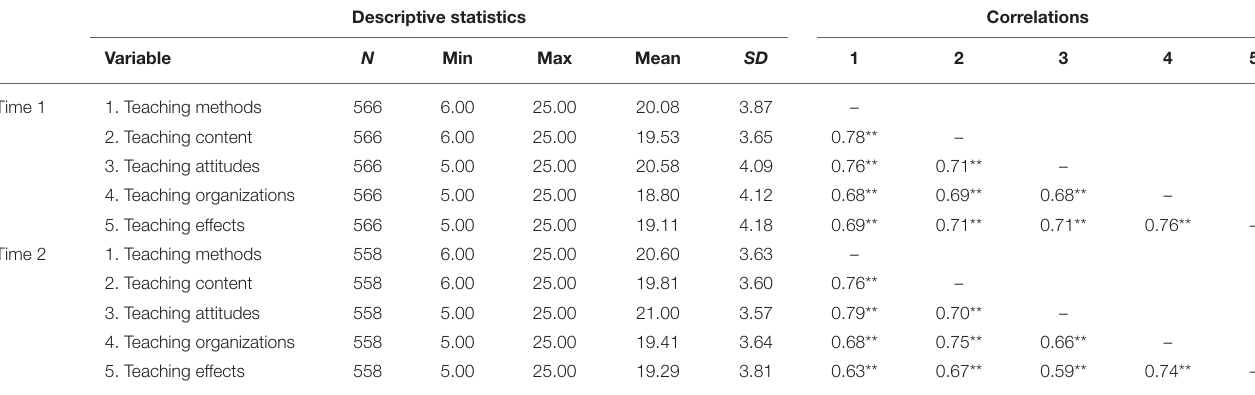
TABLE 3 | Minimums, maximums, means, standard deviations, and correlations for five